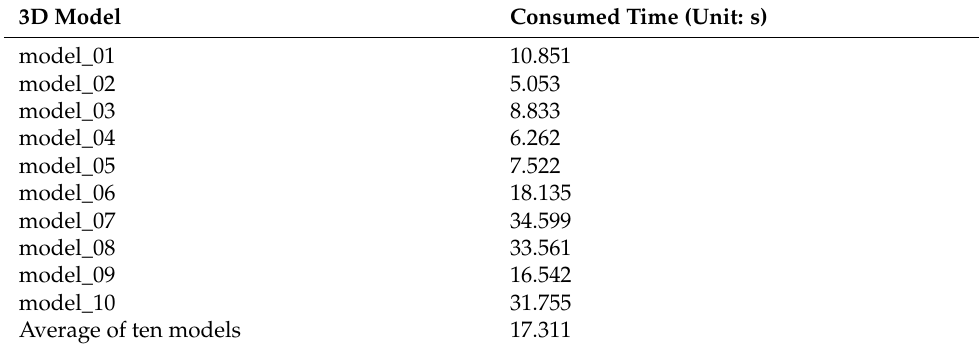
Table 3. Results of efficiency evaluation of this